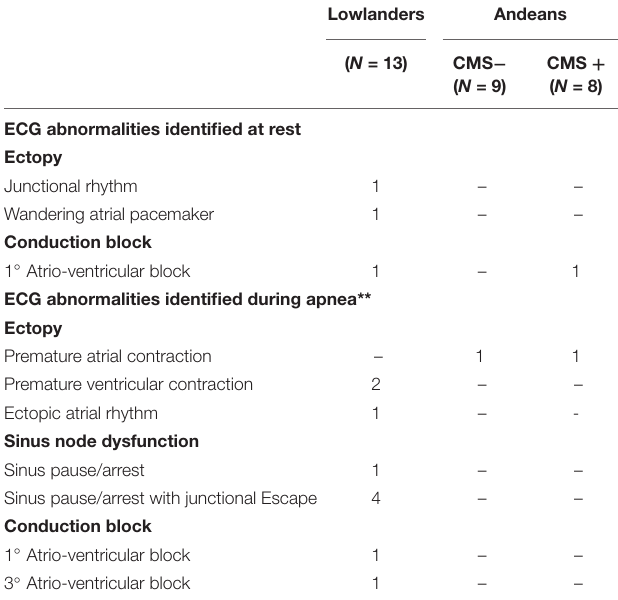
TABLE 2 | ECG Abnormalities in Andeans and Lowlanders at 4330 m at rest TABLE 1 | Participant characteristics, cardiovascular function, and resting ECG and during apnea. metrics at rest and during maximal volitional apnea. Lowlanders Andeans Lowlanders